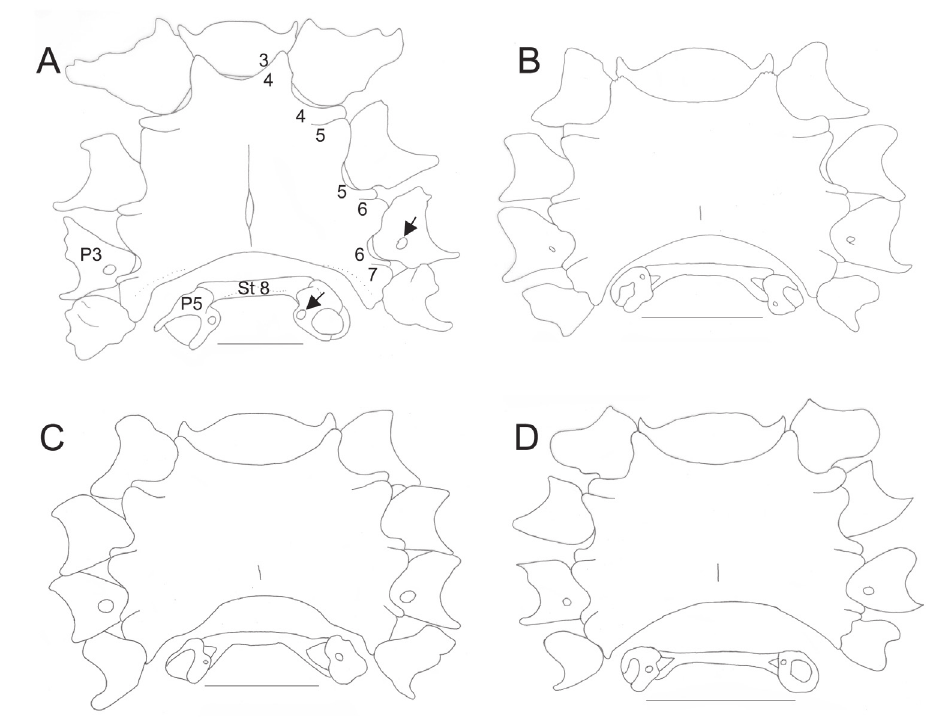
Figure 1. P1–P5 coxae and thoracic sternum of intersex specimens, ventral view. A. Lissoporcellana quadrilobata (Miers, 1884), male dominant characters, cw 8.0 mm (USNM 229590). B. Pisidia bluteli (Risso, 1816), male dominant characters, cw 3.9 mm (USNM 1277824). C. Pisidia bluteli (Risso, 1816), female dominant characters, cw 4.1 mm (USNM 1277824). D. Pisidia longimana (Risso, 1816), male dominant characters, cw 2.9 mm (USNM 152181). Abbreviations: St8, thoracic sternites 8; 3/4–6/7, thoracic sternal sutures. Arrows: female (P3) and male (P5) gonopores. Scale bars = 1